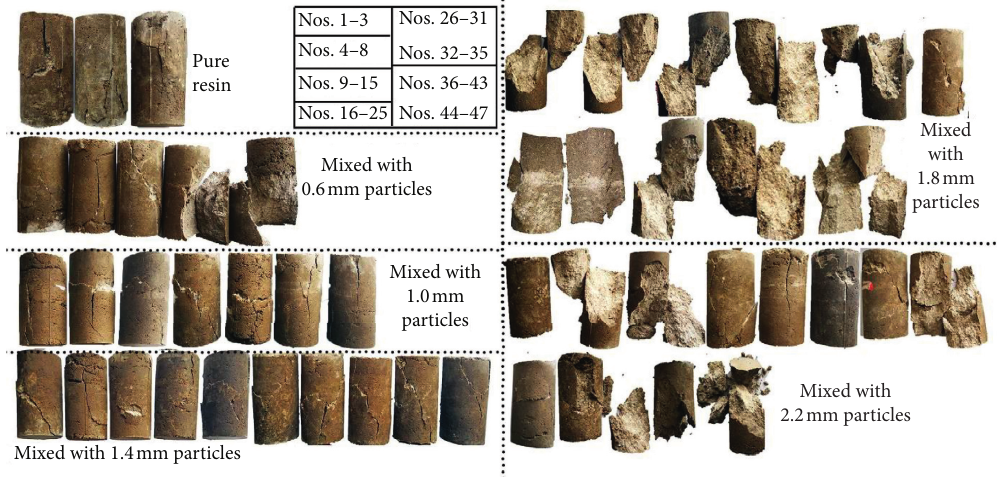
Figure 8: Failure patterns for all specimens. Note that the “No.” in the block refers to the “No.” in Table 1.